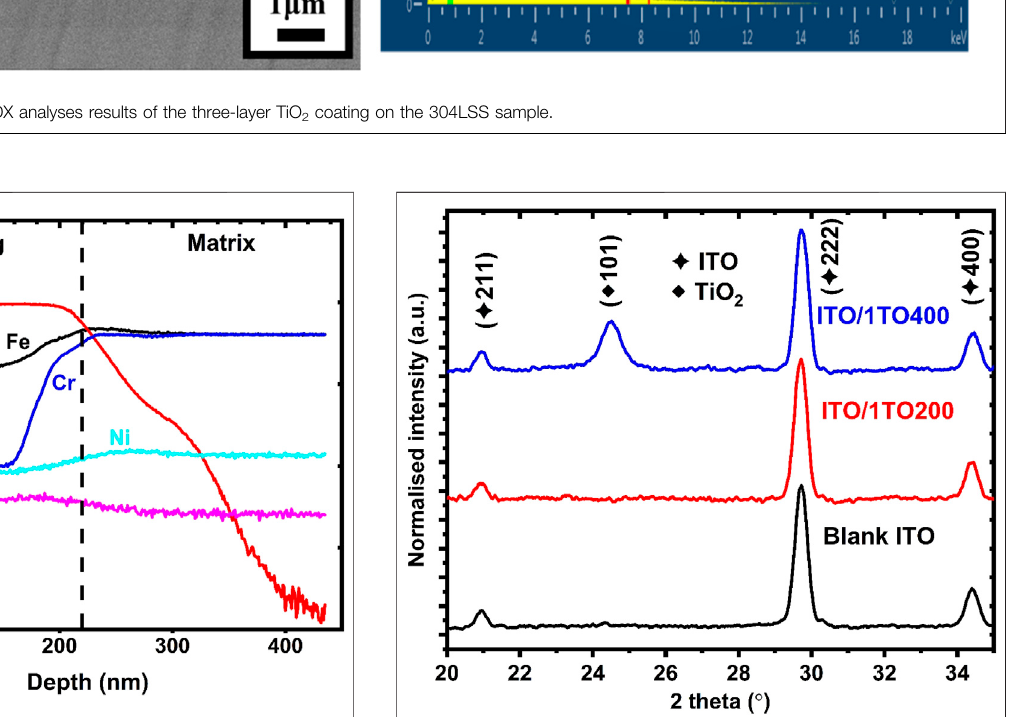
FIGURE 6 | Depth pro fi les of Fe, Cr, and Ni in the 304LSS/3TO sample.